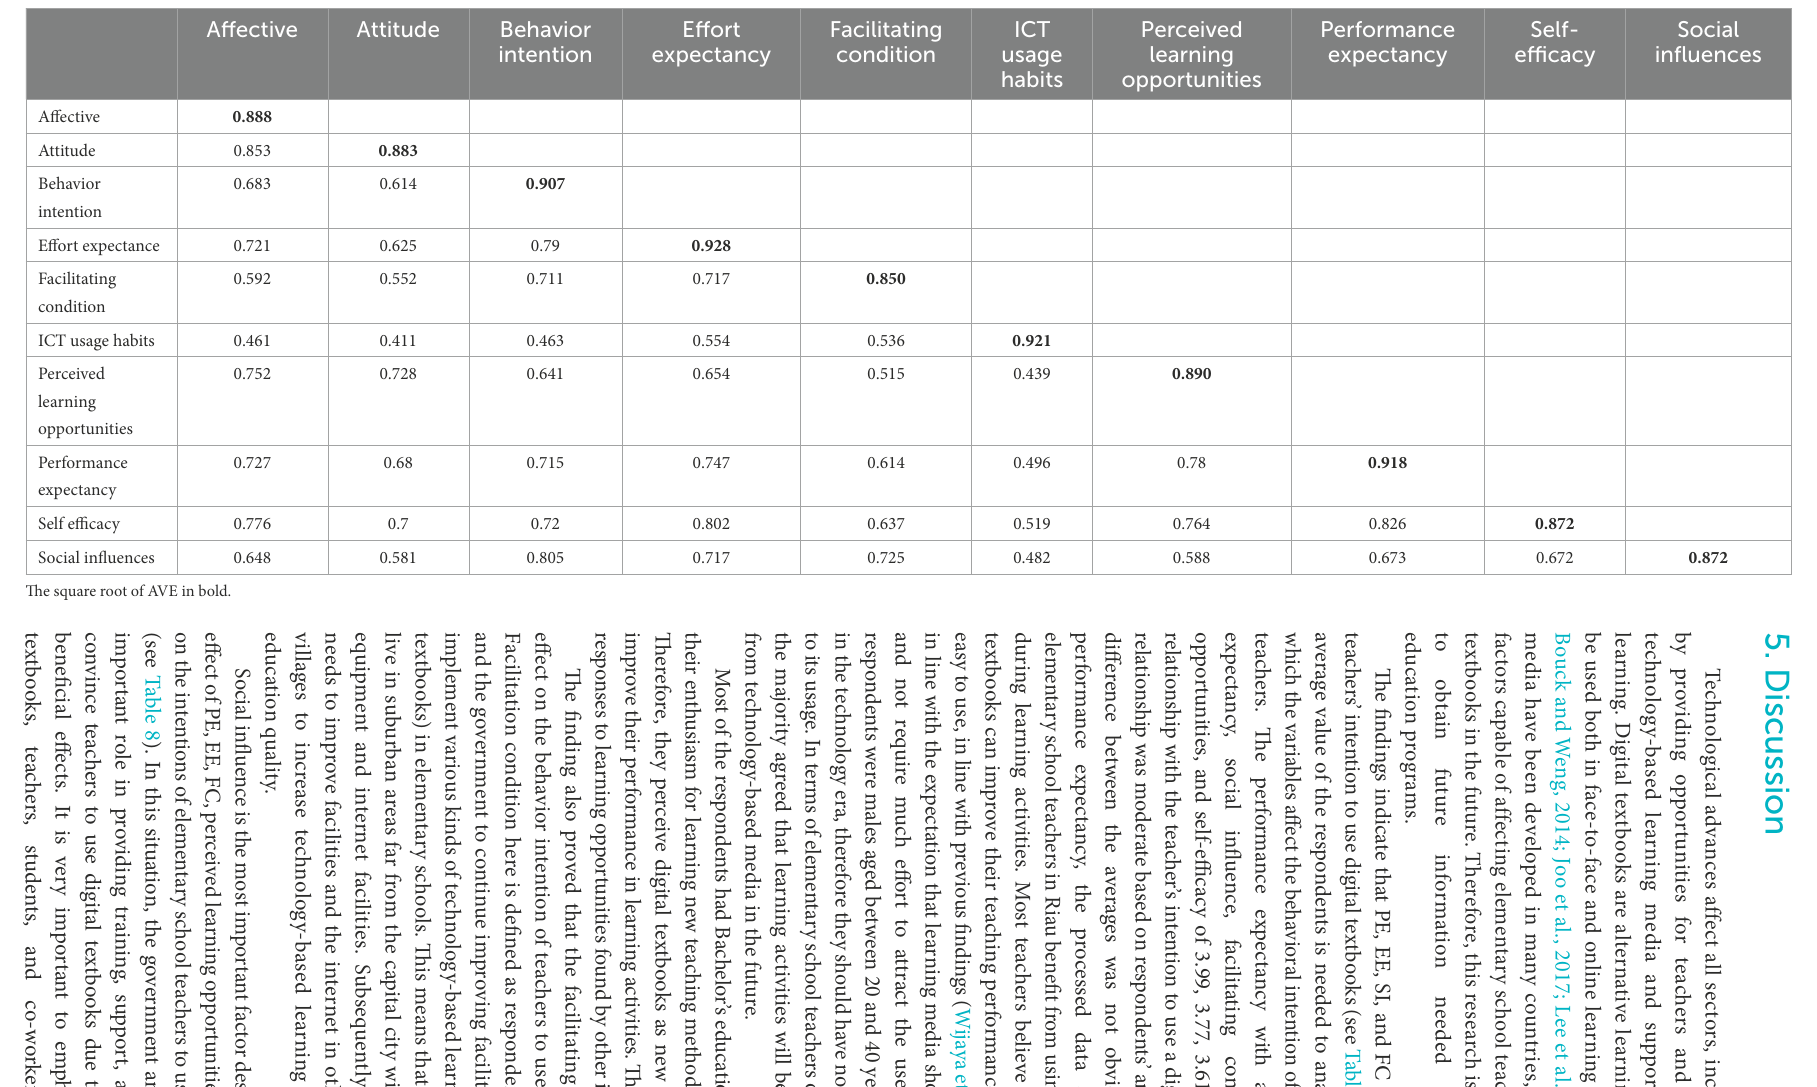
TABLE 4 Fornel–Larcker